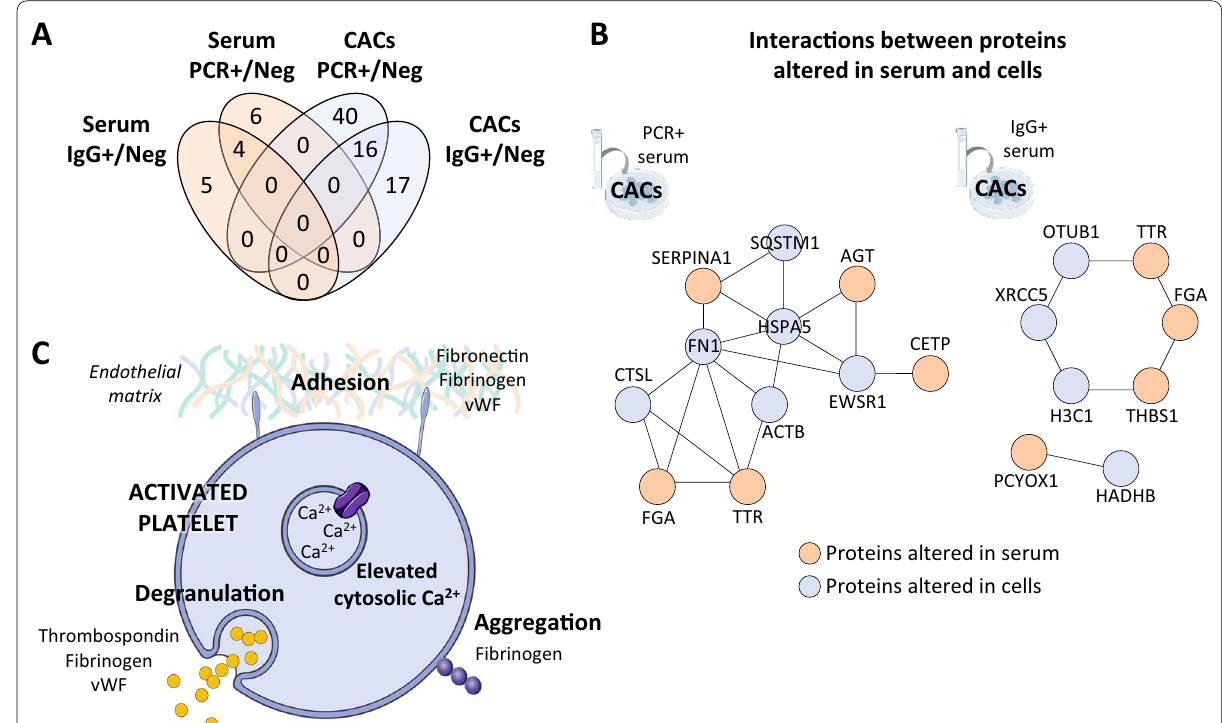
Fig. 6 Interactions between proteins altered in serum and CACs samples. A Venn’s diagram including the number of proteins up‑ or down‑regulated, common or exclusive in serum samples and CACs analysis evaluating the potential interactions between altered proteins in the serum of COVID‑19 asymptomatic donors (PCR the proteins altered in healthy CACs in response to those serums was performed with PINA v3 on‑line platform. C One of the most representative functions found between the interactions found between both sets (serum and CACs) of altered proteins was platelet activation, including platelet aggregation and degranulation. Figure obtained with